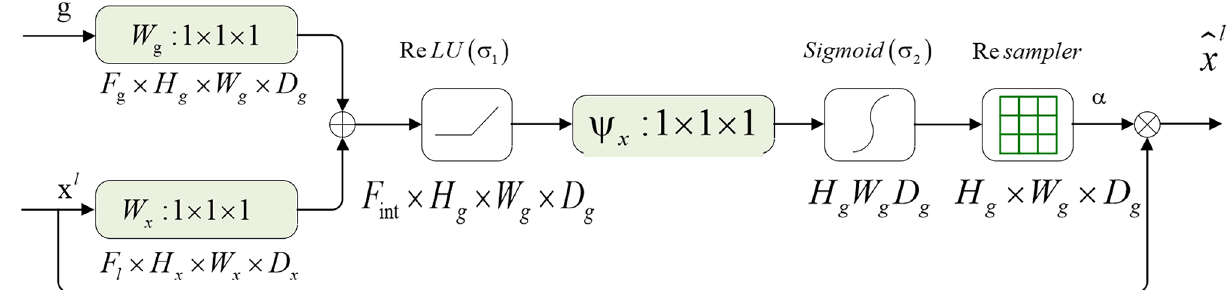
l Figure 3. The attention module schematic. Input features ( x ) are scaled with attention coefficients (α) computed in spatial attention. Spatial regions are selected by analyzing both activations and contextual information provided by the gating signal (g). ⊕ denotes add, and ⨂ denotes the elementwise